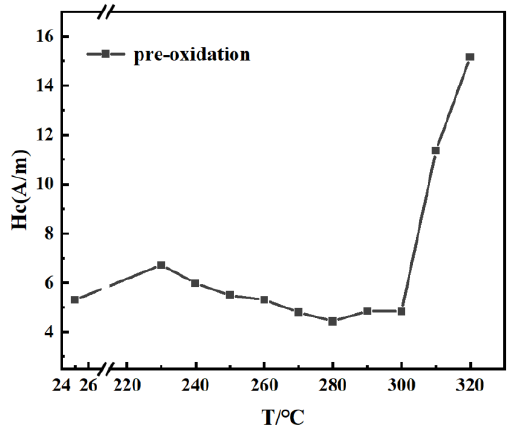
Figure 1. Hc value of 10 min pre-oxidation treated samples.